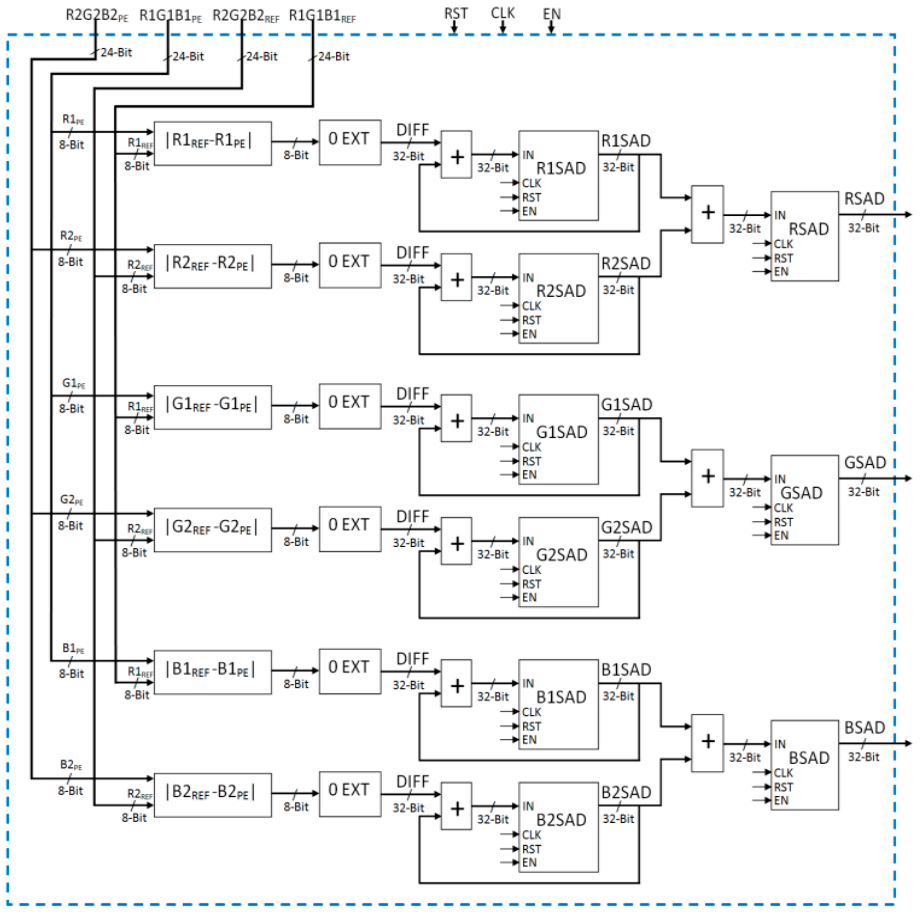
Figure 6. Proposed and implemented architecture for the SAD computation module. REF  PE → Processing Element; SAD → Sum of Absolute Difference; EXT → Extended; R → Red Color Reference; PE  Processing Element; SAD  Sum of Absolute Difference; EXT  Extended; R  Red Channel; G → Green Color Channel; B → Blue Color Channel; DIFF → Color Channel; G  Green Color Channel; B  Blue Color Channel; DIFF  Difference.